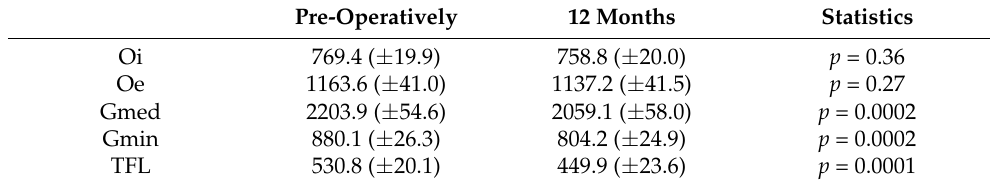
Table 2. Affected side of muscle cross-sectional area pre-operatively and 12 months post-operatively.